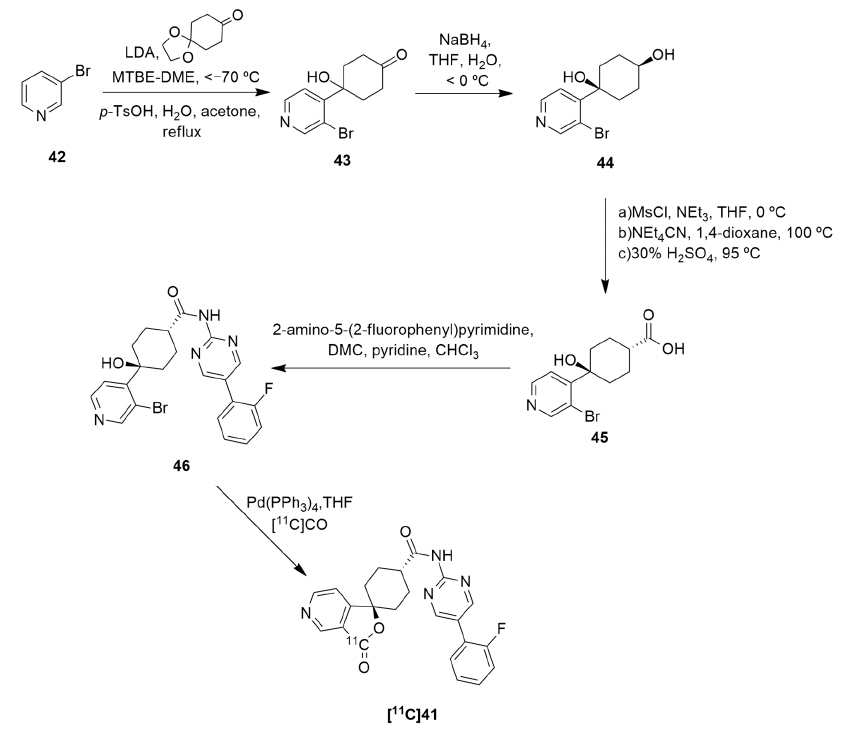
Figure 13 . Synthetic route of precursor 46 and radiosynthesis of [ 11 C]41 . Figure 13. Synthetic route of precursor 46 and radiosynthesis of [ 11 C]41